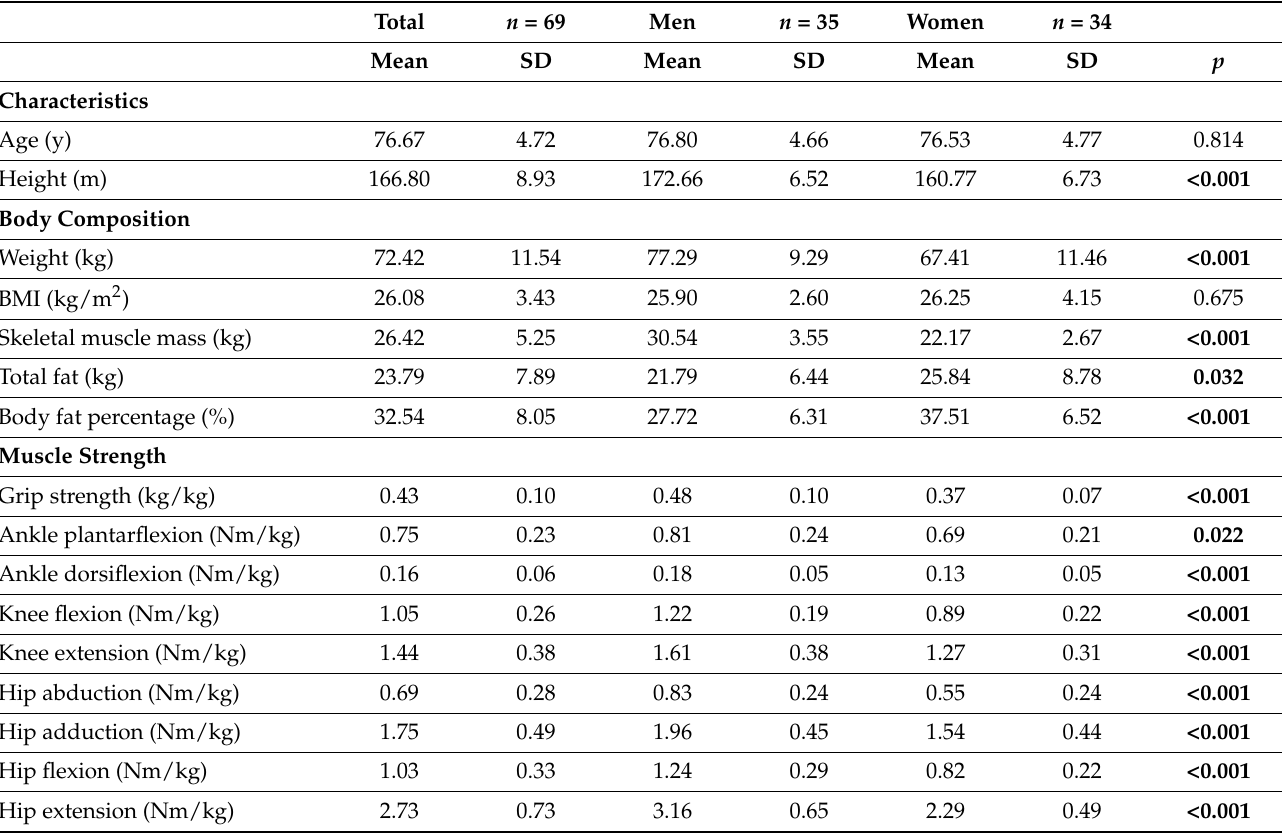
Table 1. Anthropometrics, relative strength, and gait parameters of male and female subjects.